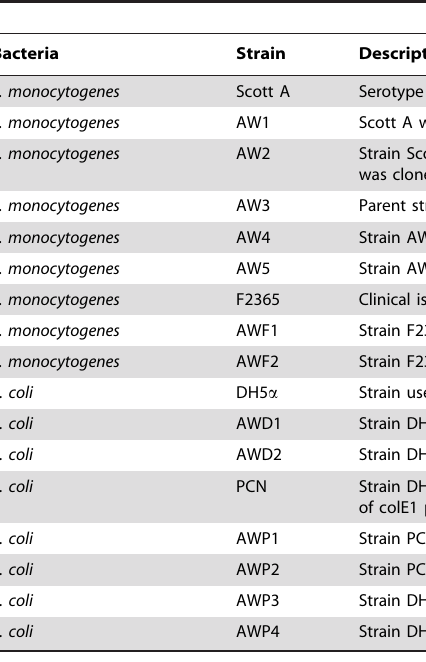
Table 1. Bacterial strains used in this study.